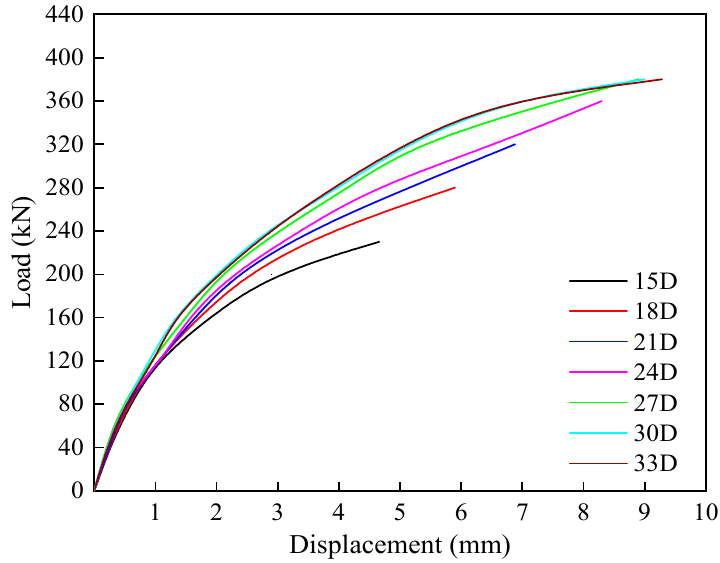
Figure 15. Bolt load–displacement curve.